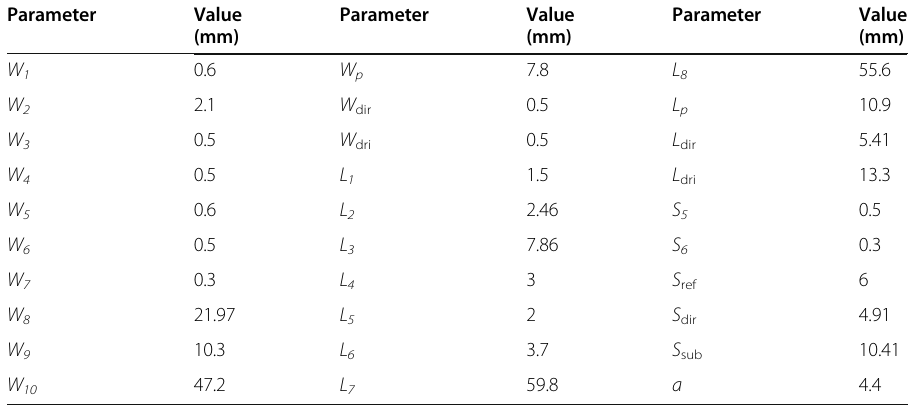
Table 1 Parameters of the proposed radiating element Parameter Value Parameter Value (mm)